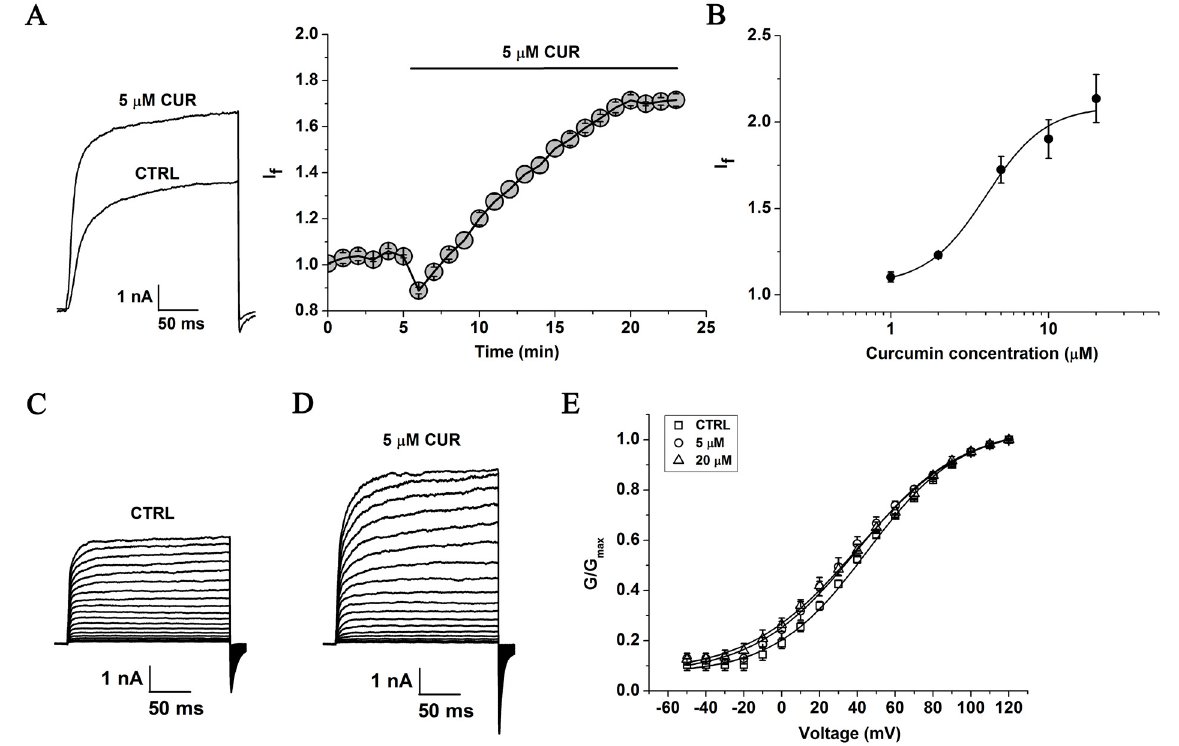
Fig 2. Effect of curcumin on exogenous BK ( α + β 1) channel currents in HEK293 cells. (A) Representative whole cell current traces from HEK293 cells expressing BK ( α + β 1) channels before and after the perfusion of 5 μ M curcumin are presented at left and the time course for the enhancement on BK ( α + β 1) channels by curcumin at right. With 3 μ M free Ca 2+ in the pipette solution, the holding voltage was controlled at -80 mV and the BK currents were evoked by the pulse of +100 mV. (B) The dose-dependence curve of curcumin enhanced BK ( α + β 1) currents was fitted by the Hill equation (see “ Data analysis ” ). The EC 50 value is 4.02 ± 0.67 μ M with a Hill coefficient of n = 2.31 ± 0.58 (n = 5). (C) HEK293 cells were held at -80 mV, and the duration of 200 ms voltage steps were applied from -50 to +120 mV at 10 mV increments. Representative trace before treatment with curcumin was shown. (D) Representative trace manifestes the effect of curcumin at the concentration of 5 μ M. (E) The plots of the normalized conductance were fitted well with Boltzmann function ( “ see Data analysis ” ). The voltage dependence of steady state activation curve was not shifted significantly in the presence of curcumin (n = 5). □ represents the curve of BK ( α + β 1) channels before exposure to curcumin. (cid:3) represents the curve of BK ( α + β 1) channels after exposure to 5 μ M curcumin. Δ represents the curve of BK ( α + β 1) channels after exposure to 20 μ M curcumin.